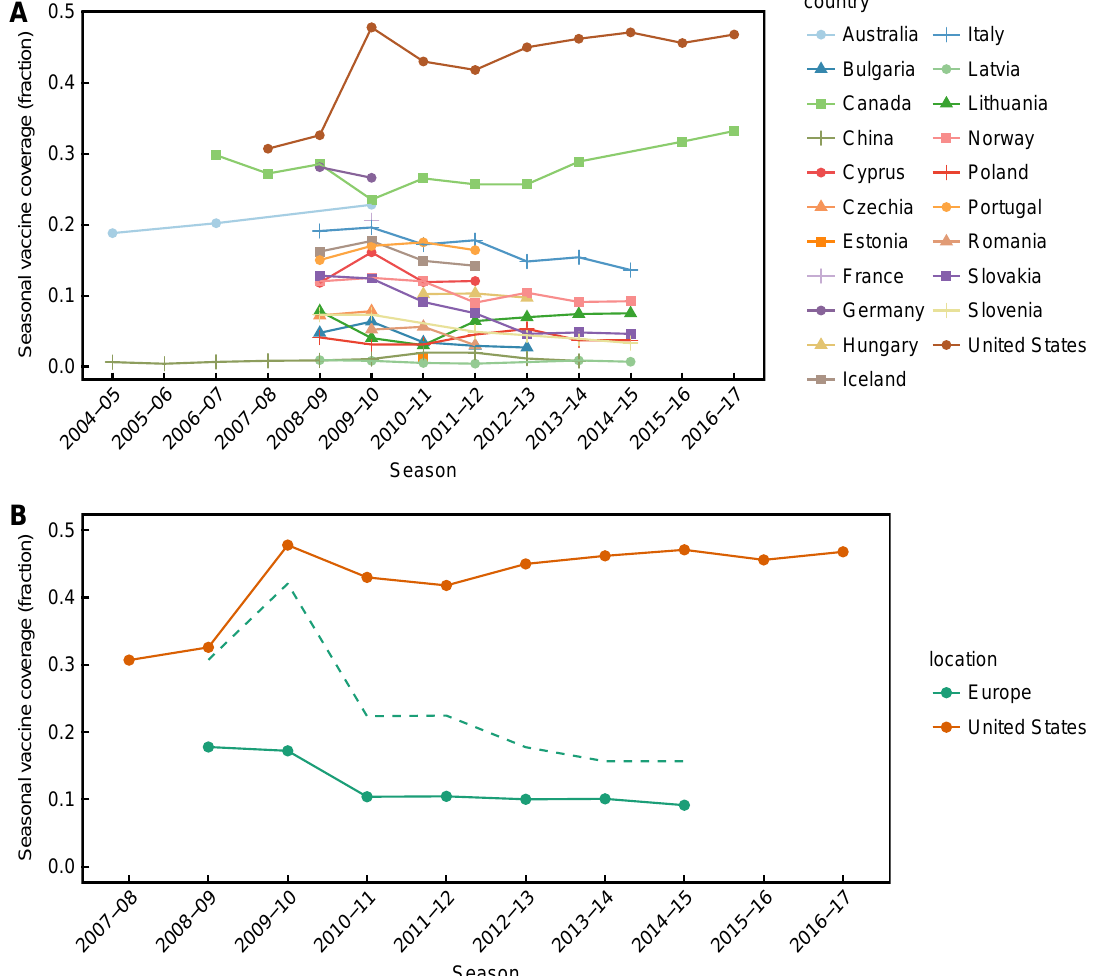
Figure A3. Seasonal vaccine coverage reported by national agencies [7,46,87–89]; vaccine coverage in China estimated from doses distributed as reported by the IFPMA IVS task force [90,91]. ( A ) vaccine coverage by country; ( B ) European vaccine coverage compared against United States vaccine coverage. The dashed line shows the total population size of countries reporting vaccine coverage divided by the total population of Europe in each